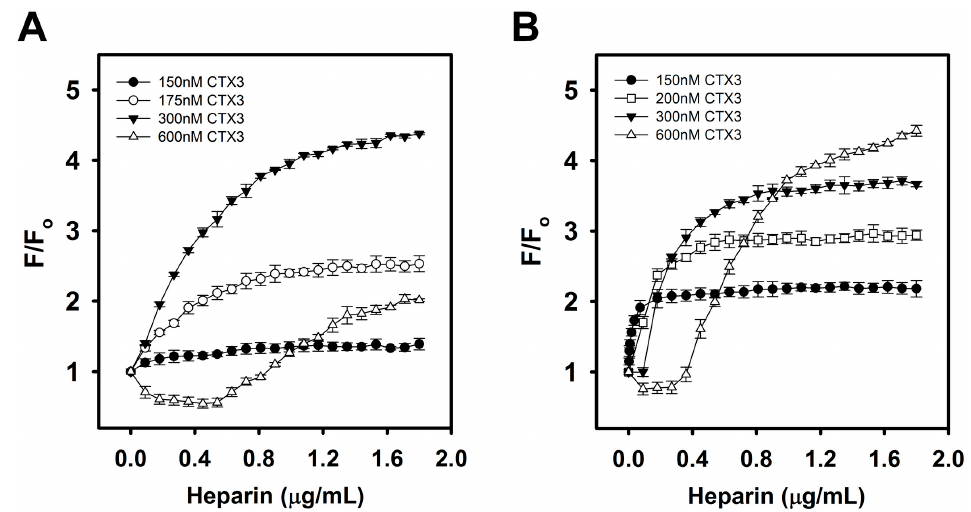
Figure 8. Effect of varying CTX3 concentrations on the turn-on fluorescence of CTX3-aptamer or CTX3-MB sensors upon the titration of indicated heparin concentrations: ( A ) aptamer and ( B ) MB were incubated with varying CTX3 concentrations for 5 min, and then CTX3-aptamer or CTX3-MB sensors were titrated with the indicated heparin concentrations.